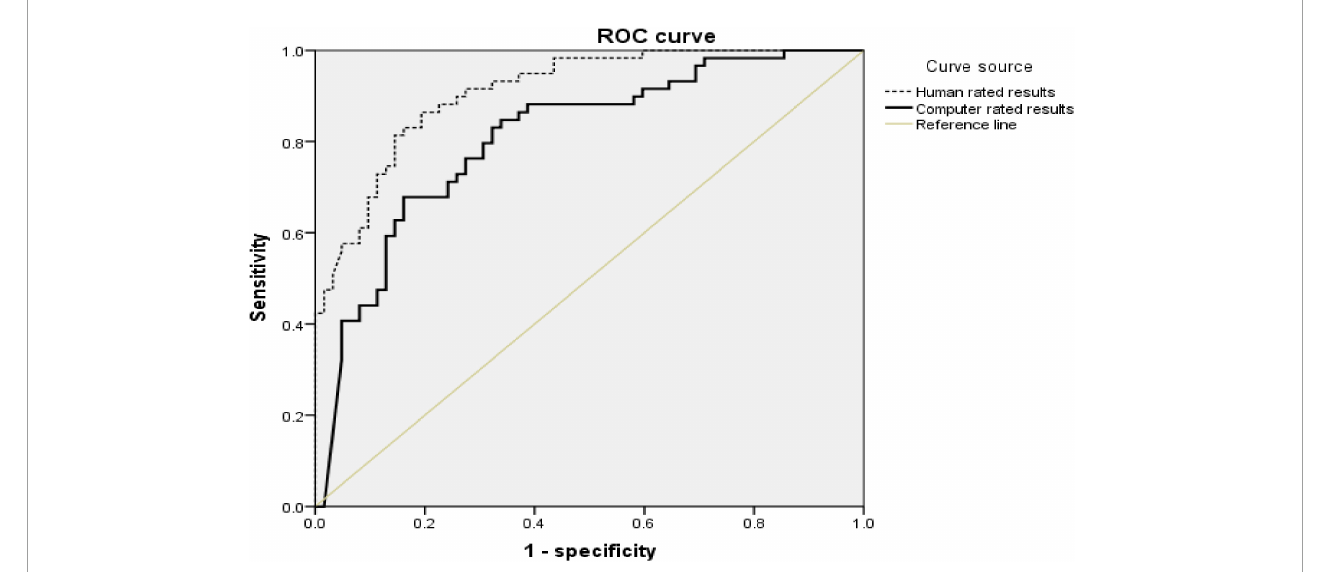
FIGURE3 ROC curves of ASD diagnosis from all sample toddlers by computer- and human-rated results.